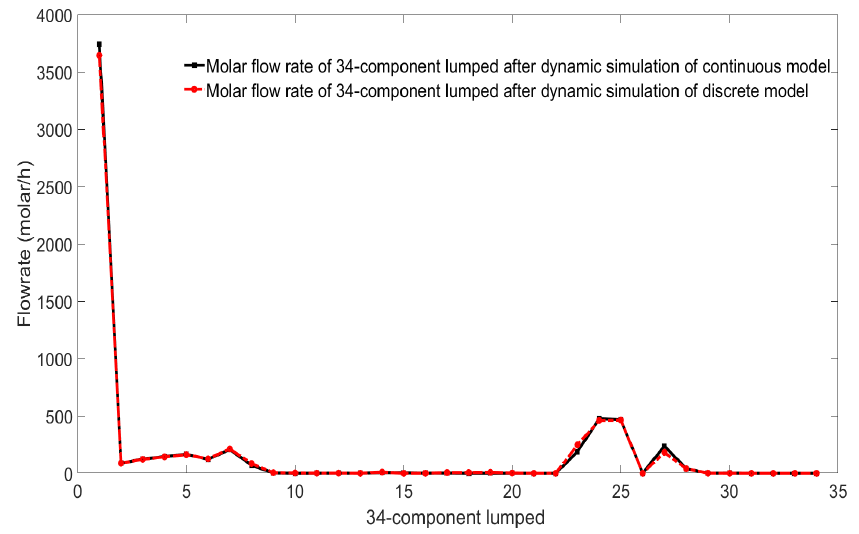
Figure 5. Comparison of the molar flow rates of the 34-component lumped at the outlet of the last reactor after the dynamic simulation of the discrete model and the continuous model.